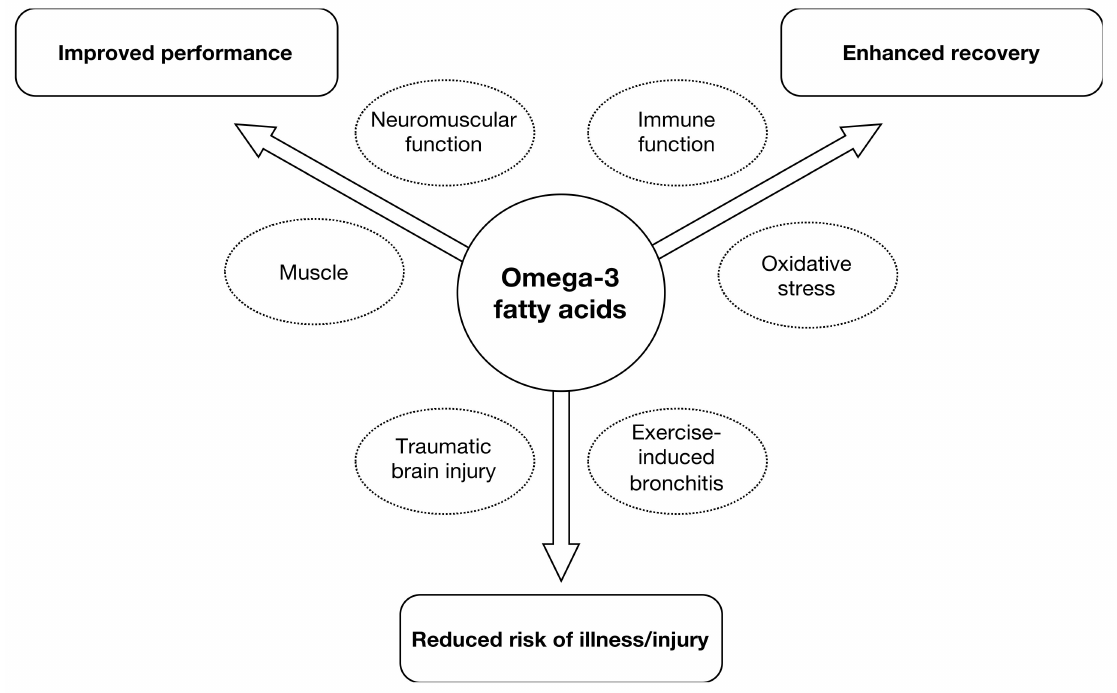
Figure 1. Areas of interest for supplementation with eicosapentanoic acid / docosahexanoic acid (EPA / DHA) in sport nutrition in athletes as well as